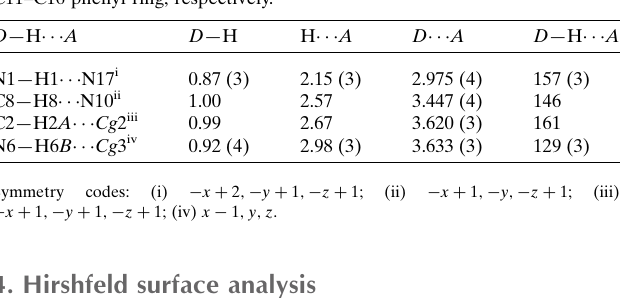
Table 1 Hydrogen-bond geometry (A˚ , (cid:3) ). Cg 2 and Cg 3 are the centroids of the N5/C6–C9/C9 A pyridine ring and the C11–C16 phenyl ring,